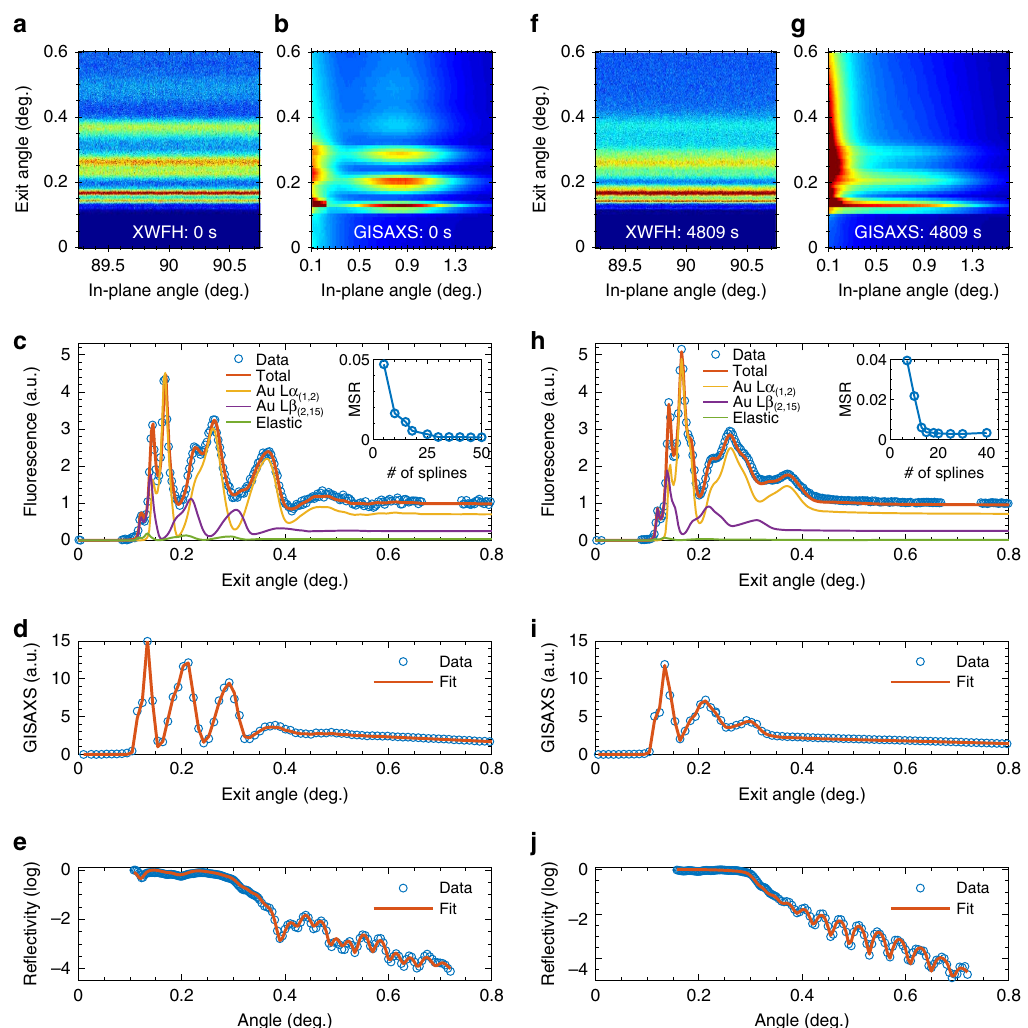
Fig. 3 XWFH, GISAXS, and re fl ectivity measured in the beginning and at the end of the thermal annealing for the LH sample. ( a ) and ( b ) are XWFH and GISAXS patterns taken at an incident angle of 0.125°. GISAXS pattern is mirror-symmetrical with respect to the forward scattering direction (i.e. 0° in- plane angle), so only the right half is shown in ( b ). c In-plane integrated experimental and reconstructed XWFH data. Individual contributions from the L α (1,2) , L β (2,15) emissions and the elastic background are displayed. The inset MSR (mean-square residual) analysis indicates that 30 cubic b-splines is suf fi cient to describe the gold atomic number density pro fi le. ( d ) and ( e ) are, respectively, GISAXS and re fl ectivity data with the best fi t. ( f – j ) are the result at the end (4809 s) of the thermal annealing. The inset in ( h ) suggests 15 cubic